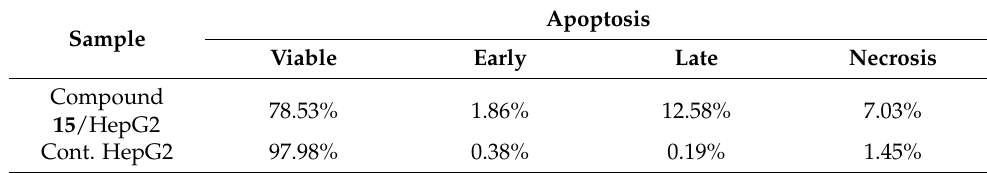
Table 4. E ff ect of compound 15 on the distribution of apoptotic cells in HepG2 cells.